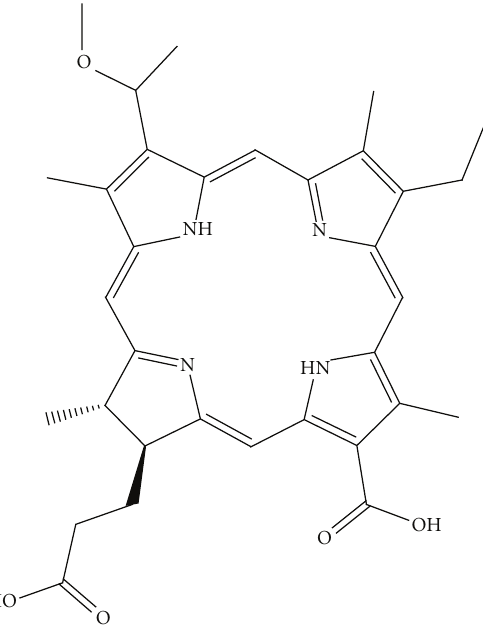
Figure 1: Molecular structure of